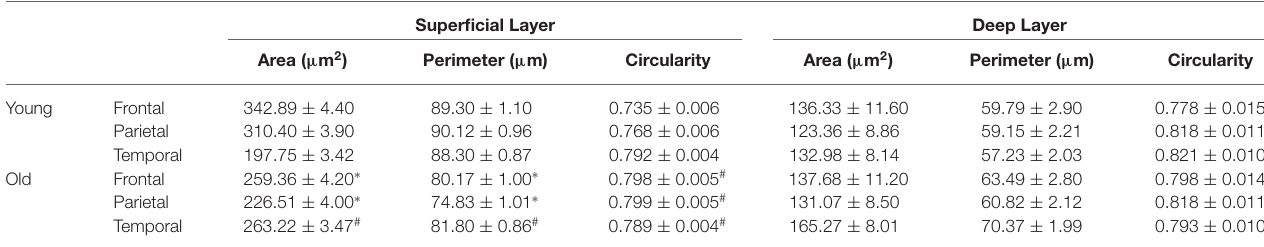
TABLE 3 | Morphometric analysis of WMNs in non-human primates (NHP) normal aging